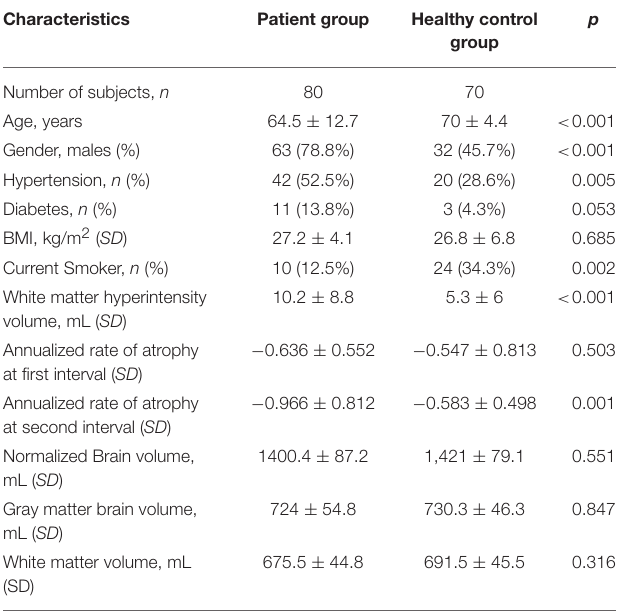
Table 3 denotes a separate mixed-effects regression model where the indicated cognitive outcome is estimated longitudinally by atrophy rate and covariates. Only the regression weights, confidence intervals, and p -values for atrophy rate are reported, while the covariates are not. Table 3 shows that there is a